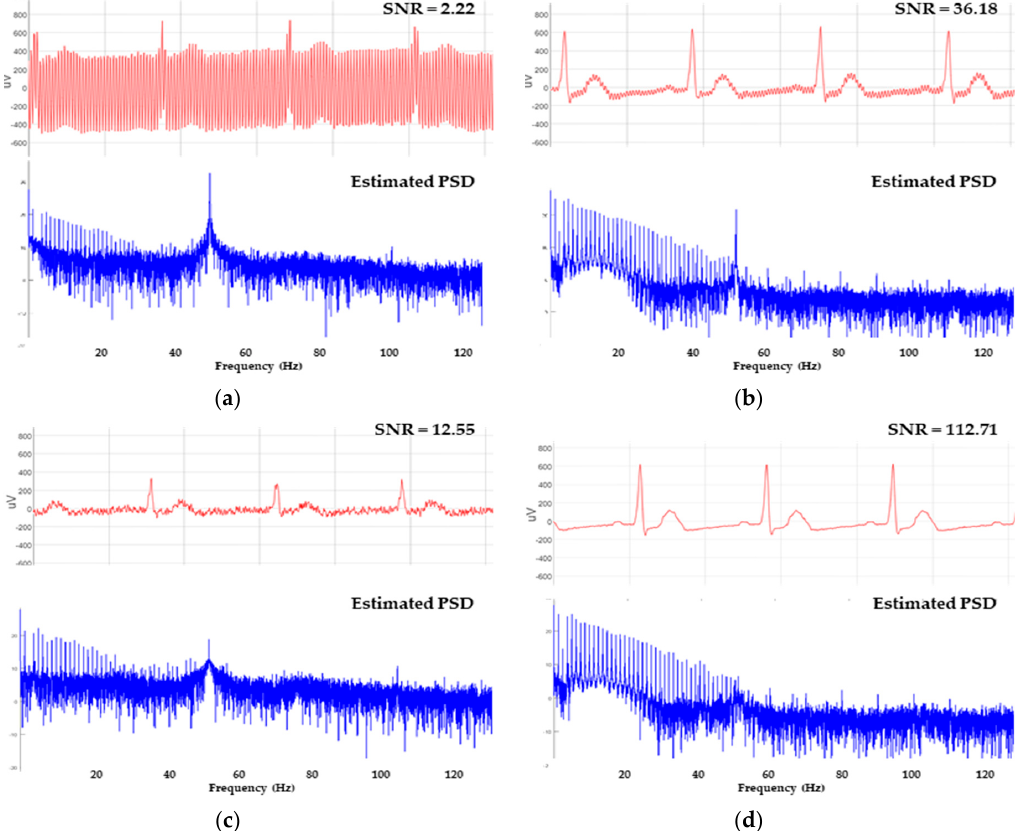
Figure 20. The 50 Hz power-line noise mitigation strategies results: ( a ) raw signal (no noise mitigation); ( b ) use of RLD circuit for common-mode noise reduction; ( c ) power-line removal using IIR notch filter; ( d ) combination of both strategies (final result).